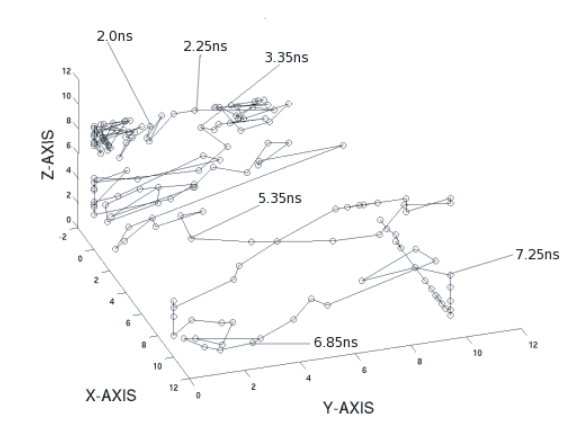
Figure 5. Identification of Transition State: Projection of the RMSD between all pairs of frames onto a 3D cartesian coordinate. The frames were 50 ps apart. The line connecting two two conformations implies sequential evolution in time. The distance between the conformations is proportional to the RMSD distances between the